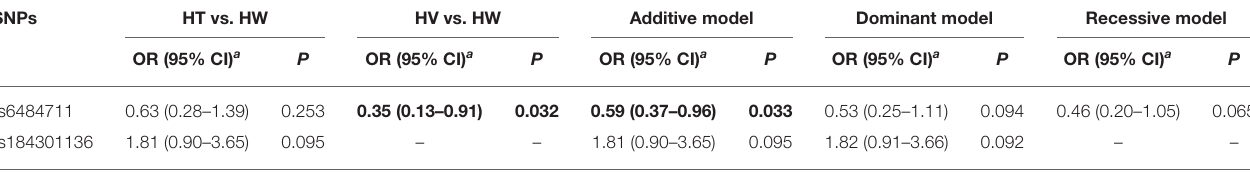
TABLE 3 | Association analyses between variants and therapeutic effect of neoadjuvant chemotherapy in the replication stage. SNPs HT vs. HW